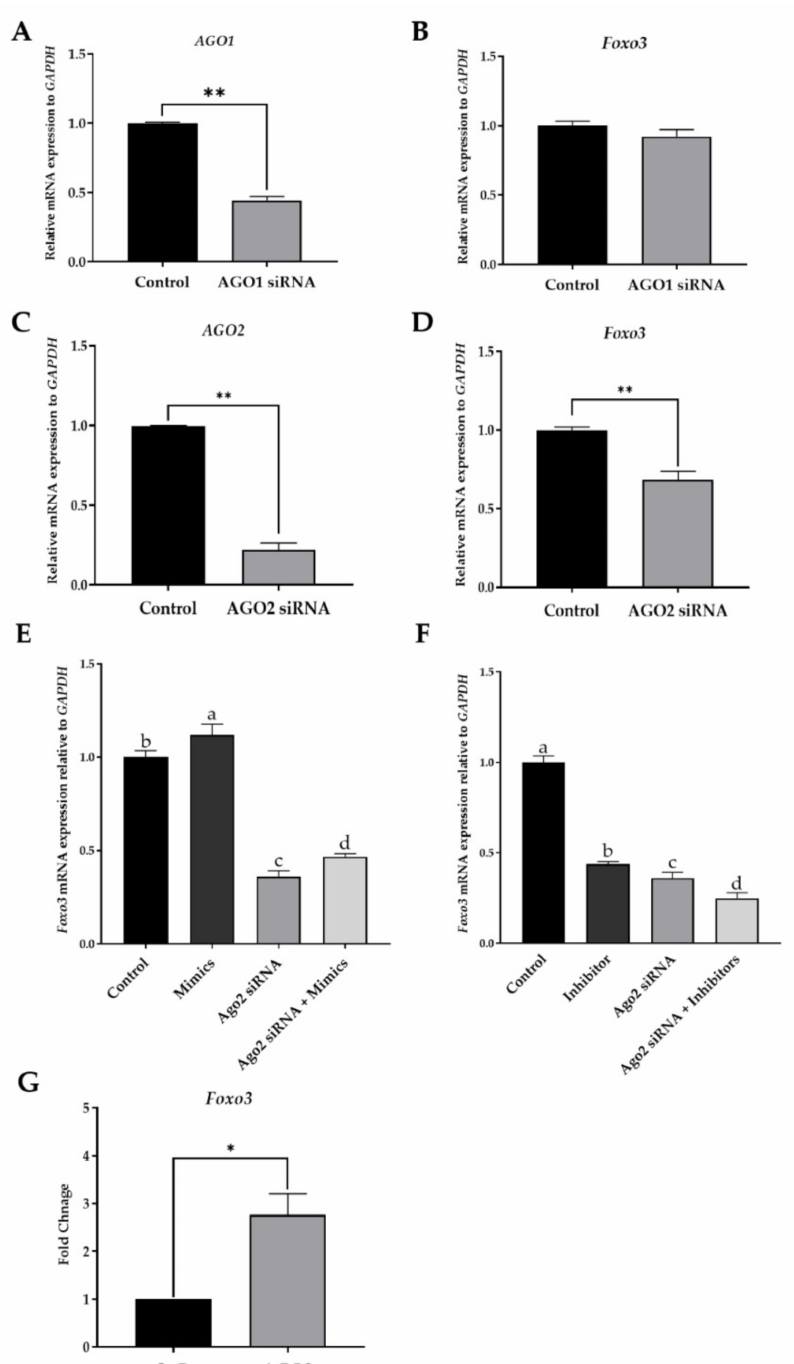
Figure 4. miR-195-5p promotes transcription of Foxo3 in CPIGCs in an AGO2-dependent manner. ( A – D ) SiRNA knockdown assay indicating the Foxo3 transcription in CPIGCs transfected with AGO1 siRNA and AGO2 siRNA. ( E ) RT-qPCR showing the mRNA level of Foxo3 in CPIGCs transfected with AGO2 siRNA and miR-195-5p mimics, respectively or together. ( F ) Foxo3 expression regulated by AGO2 and miR-195-5p inhibitor. ( G ) CHIP and RT-qPCR showing the enrichment of Foxo3 promoter in the AGO2 complex. Data are mean ± SEM of three independent experiments. * indicates p < 0.05, and ** indicates p ≤ 0.01 when compared with control. Means that were assigned different letters (a, b, c, d) were found to be significantly different ( p <